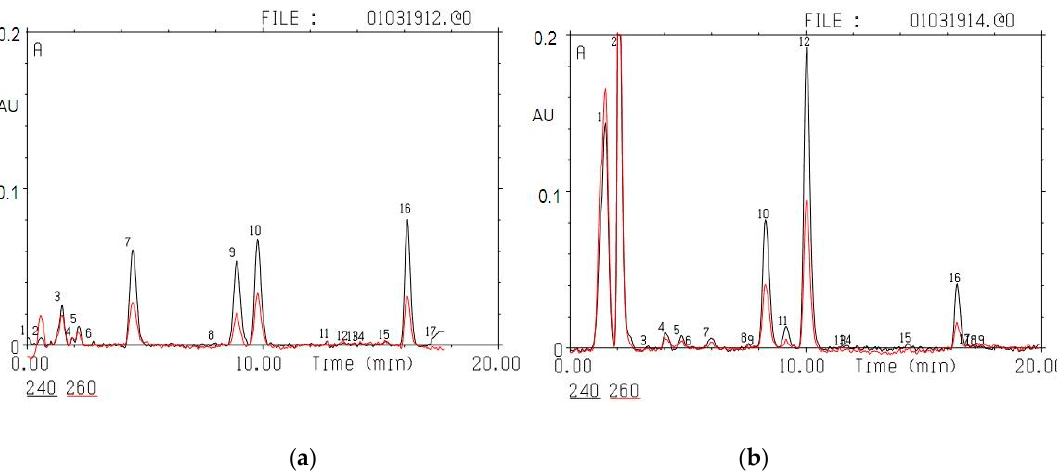
Figure 6. Chromatographic separation of a mixture of standards ( a ): 7-aldosterone, 9 – 11-dehydrocorticosterone, 10-corticosterone, and 16 – 11-desoxycorticosterone; and adrenal extracts ( b ): 5-aldosterone, 11 – 11-dehydrocorticosterone, 12-corticosterone, and 16 – 11-desoxycorticosterone. The black line corresponds to absorption at 240 nm, the red line to absorption at 260 nm. The y-axis is absorption (A) in absorption units (AU); the x-axis is time in min.